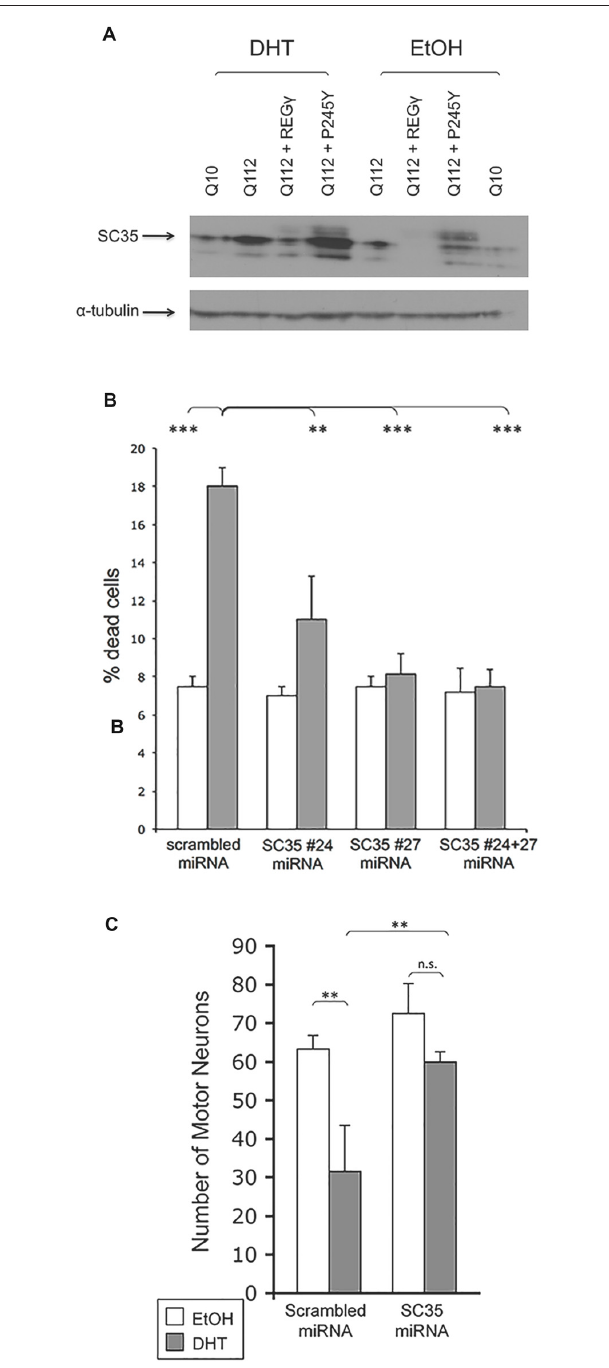
FIGURE 9 | REG γ effects may be mediated by the splicing factor SC35. (A) SC35 levels are increased in the presence of DHT in PC12 cells expressing ARQ112. REG γ overexpression ameliorates enhanced SC35 levels in a manner dependent upon its ability to bind the proteasome. PC12 cells expressing ARQ10, ARQ112 and ARQ112 + REG γ and ARQ112 + REG γ (P245Y) were treated with EtOH or DHT for 48 h, harvested and Western analysis was performed to determine SC35 levels. (B) Knockdown of SC35 rescues PC12 cells expressing ARQ112 from DHT-dependent